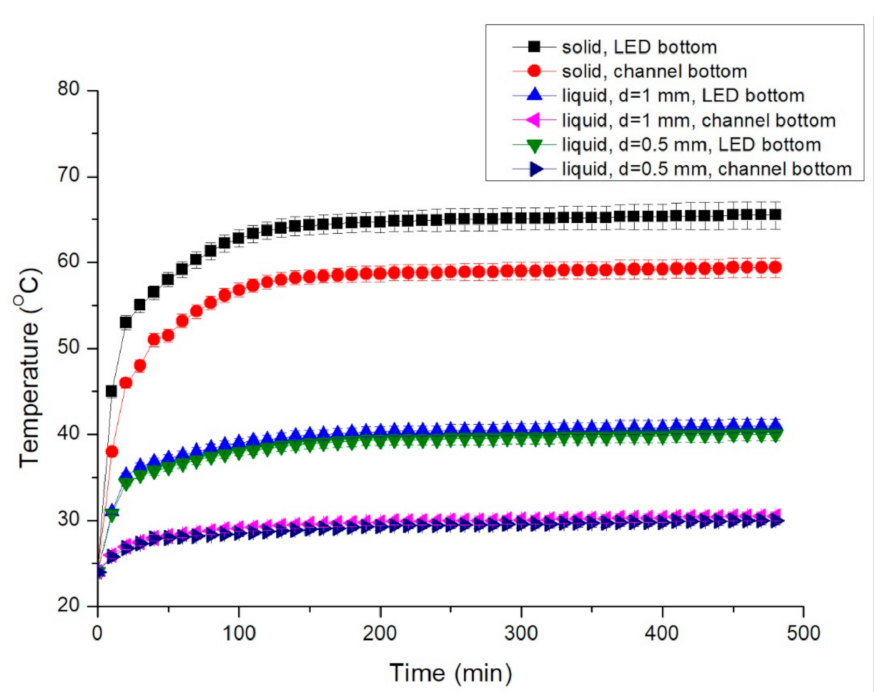
Figure 7. Temperatures of the bottom of the LED bottom and channel bottom with various conductors. The temperature differences of the LED bottom between initial and 480 min using solid conductor and graphene solution with various flow rates are shown in Figure 8. The temperature difference using the solid conductor was 35.1 ◦ C. The temperature differences using the graphene solution were 17.2, 13.4, 11.5 and 10.1 ◦ C at flow rates of 0, 0.05, 0.2 and 1 mL/min, respectively. When the flow rate was increased, the temperature difference was lower and the heat dissipation of the graphene solution was excellent. The heat dissipation of the graphene solution was apparently higher than that of the solid conductor. At static state, the heat dissipation of the graphene solution was still higher than that of the solid conductor.